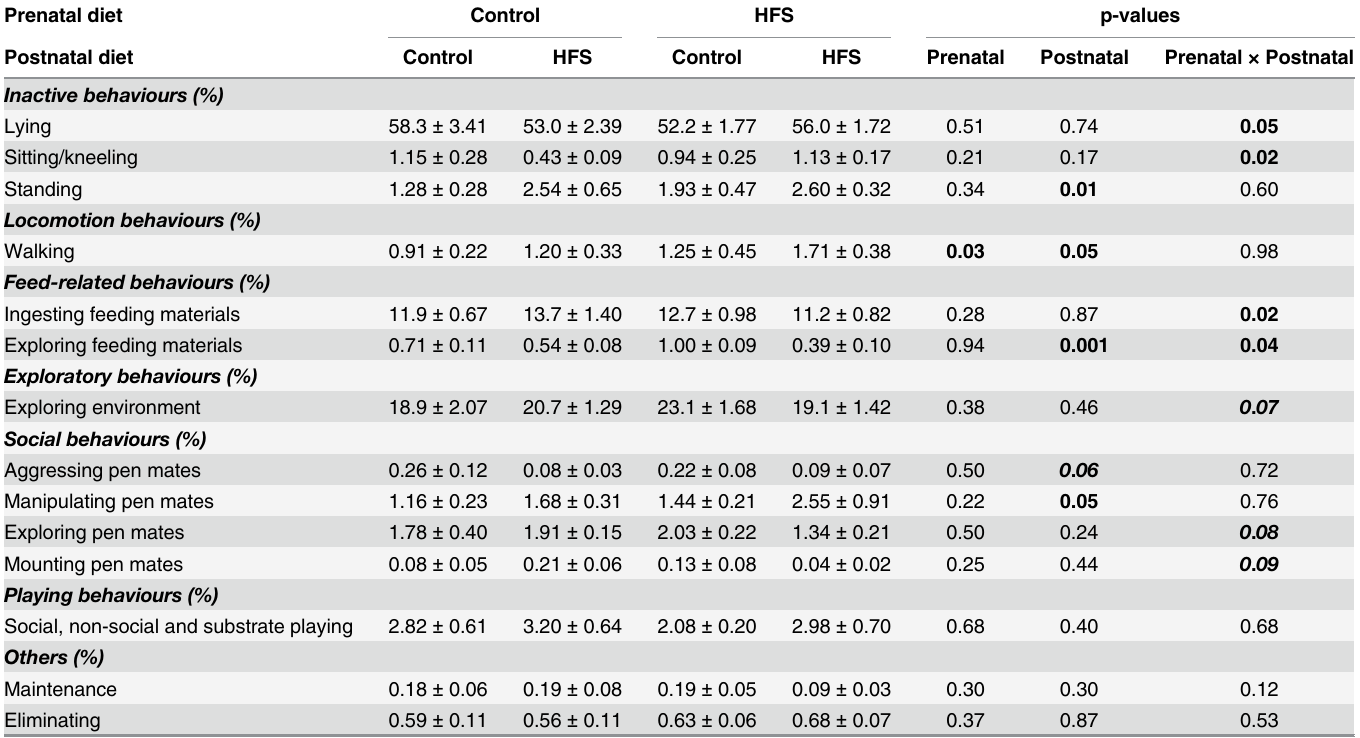
Table 4. Behavioural activity of piglets in the home pen 15 and 27 days after